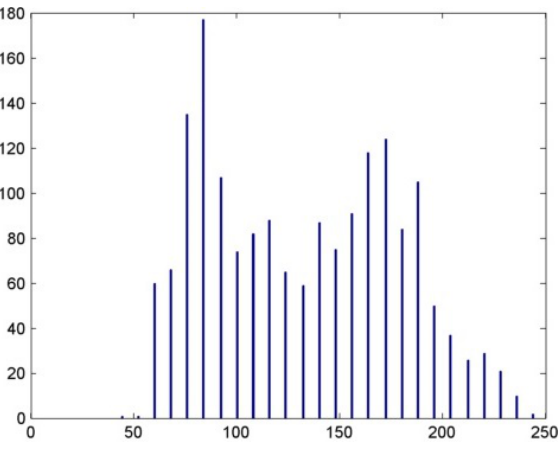
Figure 8. Histogram of the image horse .